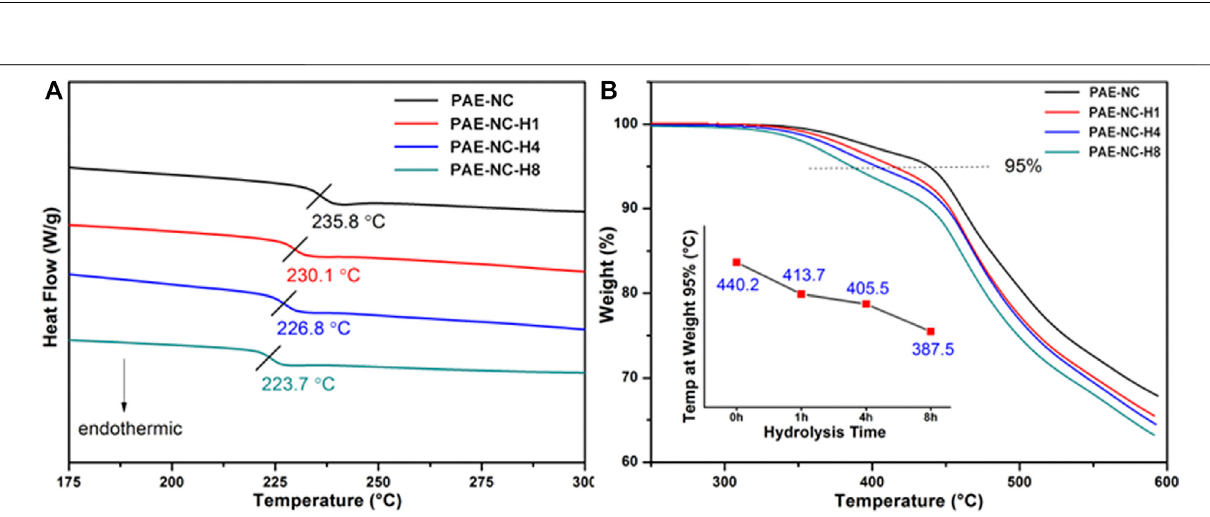
Frontiers in Chemistry |